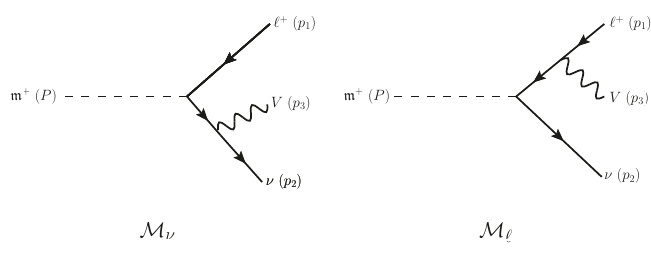
Figure 32 . Feynman diagrams contributing to the process m +